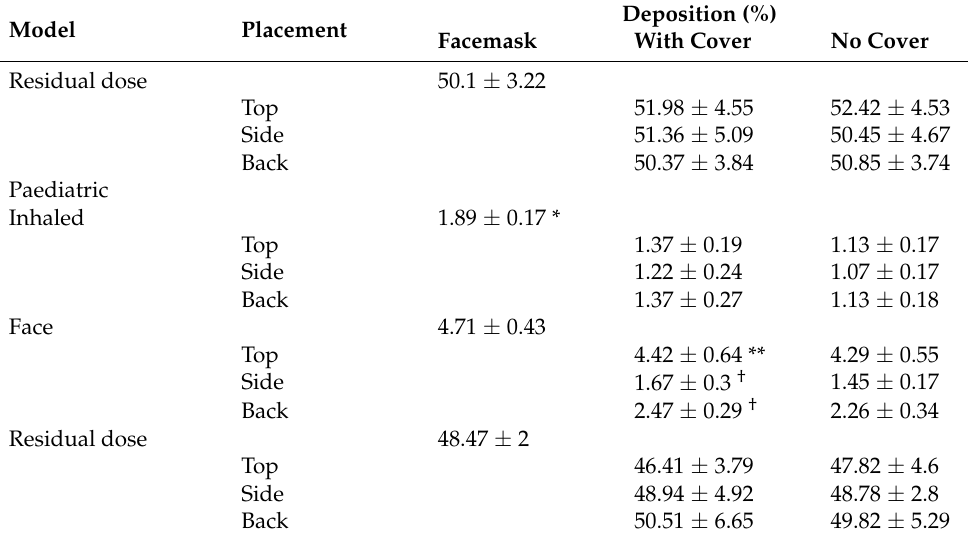
Table 1. Cont. Model Placement